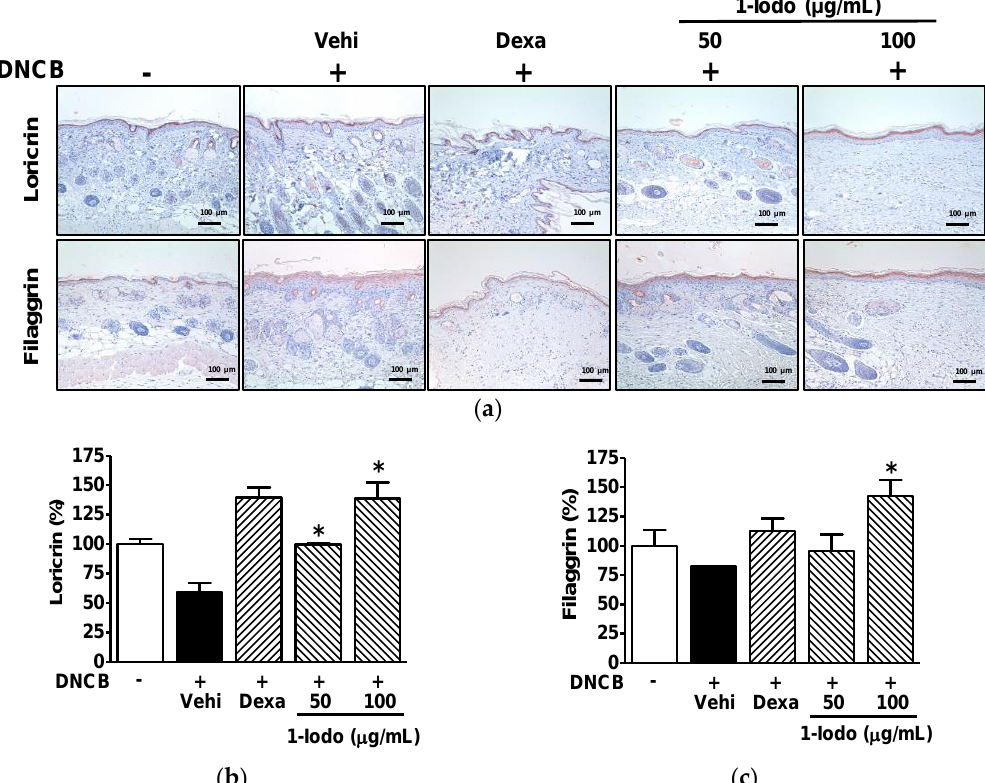
Figure 6. Expressions of skin barrier-related proteins in the skins of mice treated with DNCB and 1-iodohexadecane. ( a ) Representative images. The dorsal skins of mice were treated with 2,4-dinitrochlorobenzene (DNCB) with or without 1-iodohexadecane (1-Iodo; 50 or 100 μg/mL) for 21 days. Skin tissues were excised, fixed with 4% formaldehyde, embedded in paraffin, and sectioned, and sections were then immunostained with anti-loricrin or -filaggrin as described in the Materials and Methods section. Scale bar = 100 μm. ( b , c ) Results obtained from panel ( a ). The expression levels of loricrin (upper images of panel ( a ), n = 3) and filaggrin (lower images of panel ( a ), n = 3) were measure using Image Pro Plus. Protein levels are expressed as percentages of those of DNCB-untreated controls. Dexamethasone (Dexa, 0.1%) was used as a positive control. Values are means ± SEMs. * p < 0.05 vs. the DNCB control group. Vehi, vehicle (100% olive oil).